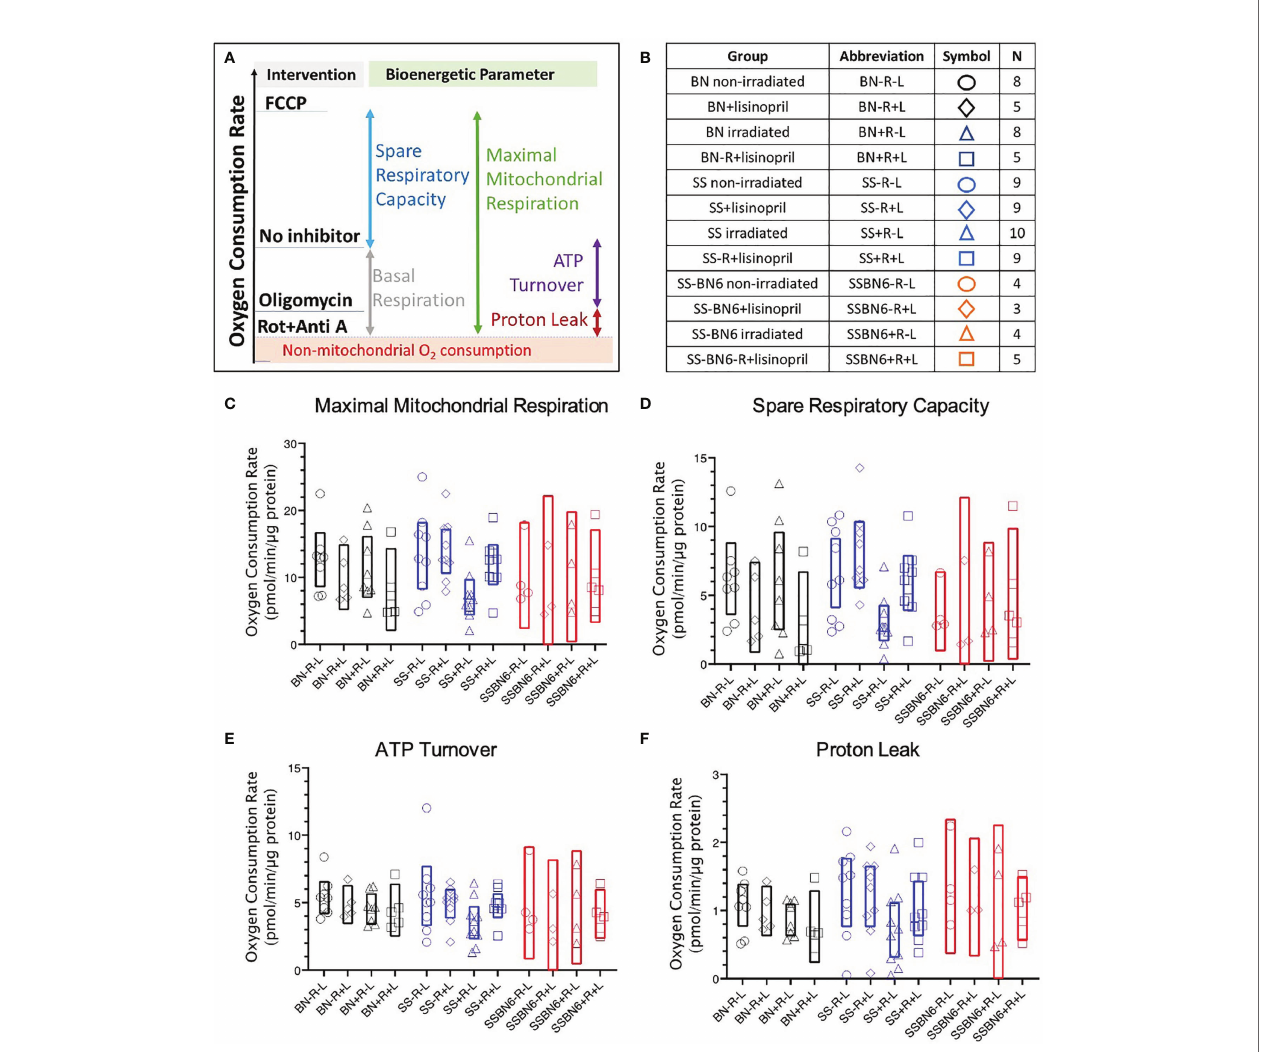
FIGURE 6 | Oxygen consumption rates in peripheral blood mononuclear cells (PBMCs). (A) Schematic showing the effects of pharmacological agents on oxygen consumption by PBMCs as investigated by the Seahorse Cell Mitochondrial Stress Test (see Methods ). If the respiratory chain activity is blocked with Rotenone and Antimycin A (designated as Rot+Anti A) then only non-mitochondrial oxygen consumption remains (shaded and marked in red). The difference between oxygen consumption without an inhibitor and with Rotenone and Antimycin A represents basal mitochondrial respiration (grey bar). Mitochondrial oxygen consumption that is driven by H+ fl ux through ATP synthase is inhibited by oligomycin. The difference between oxygen consumption without an inhibitor and in the presence of oligomycin gives the oxygen consumption coupled with ATP production (purple bar). The difference between oligomycin-inhibited respiration and non-mitochondrial oxygen consumption gives the proton (H+) leak (maroon bar). The uncoupler FCCP enhances oxygen consumption (blue bar that represents spare respiratory capacity) to yield maximal mitochondrial respiration (green bar). (B) Table showing numbers of rats in each group for graphs C-F. Oxygen consumption rates in BN (black), SS (blue) and SSBN6 (red) rats at 90 days post-irradiation. Circles = non-irradiated rats, diamonds = nonirradiated rats given lisinopril, triangles = irradiated rats, squares = irradiated rats given lisinopril. Values are expressed as pmol/minute/microgram protein. (C) Maximal mitochondrial respiration. Values were derived as the difference after treatment with the uncoupler FCCP and the non-mitochondrial oxygen consumption rate (represented by green bar in Panel A). FCCP increases the proton fl ow across the inner mitochondrial membrane creating a H + short circuit to maximize oxygen consumption (p=0.020, SS irradiated rats (SS+R-L) versus SS non-irradiated rats (SS-R-L), p=0.040, SS irradiated rats (SS+R-L) versus SS non-irradiated rats treated with lisinopril (SS-R+L)). There was no difference between other groups. (D) Spare Respiratory Capacity derived as the difference between treatment with FCCP and followed by subtraction of the basal oxygen consumption rate in the absence of any inhibitor (represented by blue bar in Panel A), (p= 0.019, SS irradiated rats (SS+R-L) versus SS non-irradiated rats (SS-R-L); p=0.023, SS irradiated rats (SS+R-L) versus SS non-irradiated rats treated with lisinopril (SS-R+L)). There was no difference between other groups. (E) ATP turnover after treatment with the ATP synthase inhibitor, oligomycin, and subtraction of the basal oxygen respiration values in the absence of any inhibitor (represented by purple bar in Panel A) (p= 0.037 (t -test, not ANOVA) for SS irradiated rats (SS+R-L) versus SS non-irradiated rats (SS-R-L)). There was no difference between other groups. (F) Proton (H+) Leak derived by the difference in oligomycin and the non-mitochondrial oxygen consumption rates (represented by maroon bar in Panel (A) . Oligomycin inhibits ATP synthase but not uncoupled mitochondrial oxygen consumption from proton leak (p=0.036 (t -test, not ANOVA), SS irradiated rats (SS+R-L) versus SS non-irradiated rats (SS-R-L)). There was no difference between other groups. Values in rats treated with lisinopril were not different from non-irradiated controls for all mitochondrial respiratory parameters represented in (E, F)